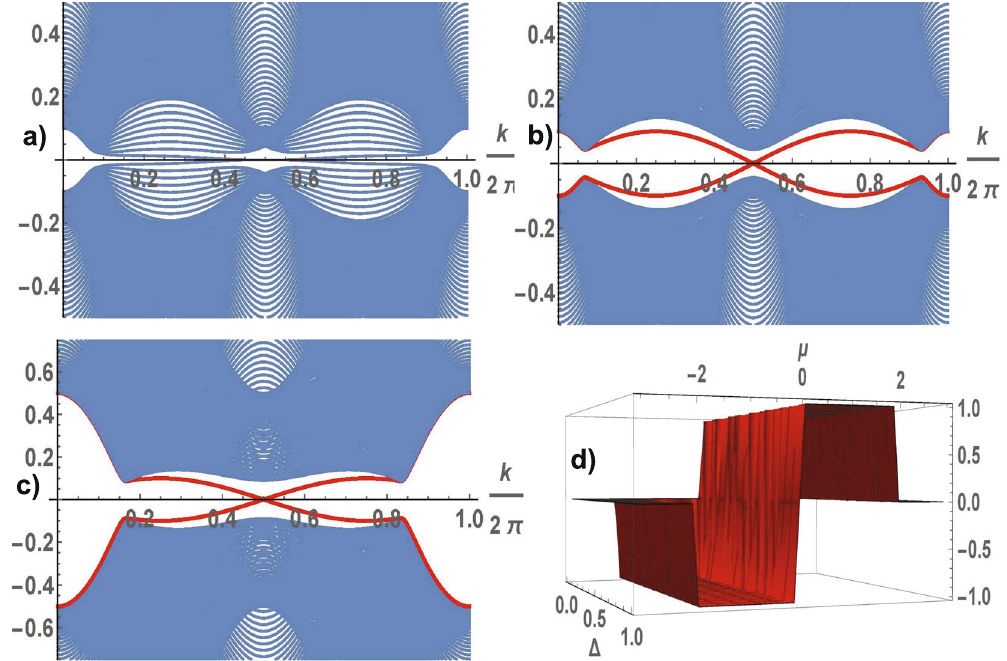
Figure 3. Low energy spectra of the one-dimensional strip along the x -direction as a function of the momentum directed along the edge. The energies are calculated for the following parameter sets: the gapless state with φ = 0 at μ = 0.1, Δ = 0.1 ( a ); the TSC gapped state with φ = π at μ = 0.1, Δ = 0.1 ( b ), μ = 0.5, Δ = 0.1 2 ( c ). In the TSC state the edge modes cross the gap connecting the lower and upper bands and intersect at k = π . The Chern number as a function of Δ and μ ( d ): a strong-pairing trivial phase with C = 0 at | μ | > 2, a weak- pairing topological phase with C = ± 1 at 0 < | μ | < 2.